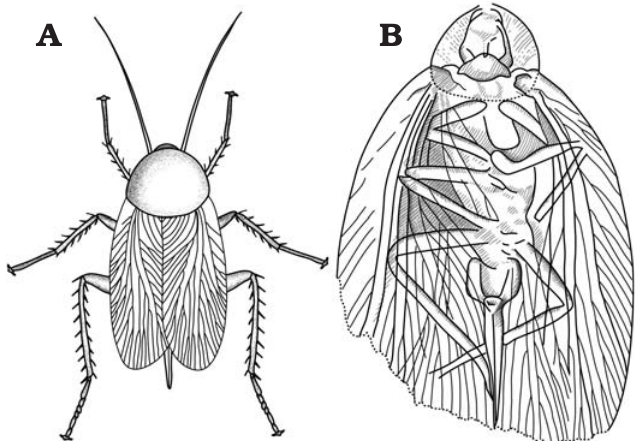
Fig. 15. Adult Carboniferous roachoids. A . Reconstruction of Etoblattina mazona Scudder, 1882, redrawn from Sellards (1904), primarily based on a specimen from Mazon Creek showing the pronotum, two forewings, and below them parts of the hindwings, but no ovipositor. Sellards (1904: figs. 10–14) assumed that the nymphs from Mazon Creek are conspecific with E. mazona . The here shown reconstruction based on his assumption is not provable. B . Drawing of Anthracoblattina ensifera Brongniart, 1894, re- drawn from Laurentiaux (1951). Brongniart (1889) was the first who noted the presence of an external ovipositor in late Palaeozoic blattoids in his description of A. ensifera (hence the given specific epithet). Not to